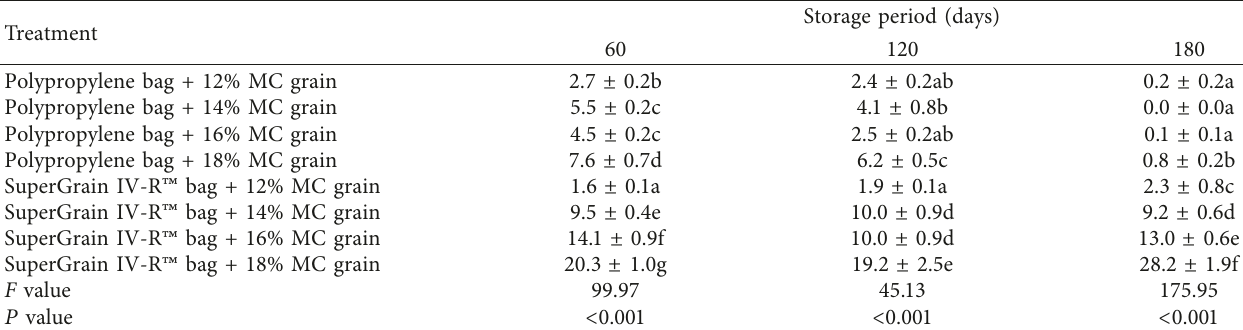
Table 2: Mean ( ± SE) percent grain discolouration after 60, 120, and 180 days of